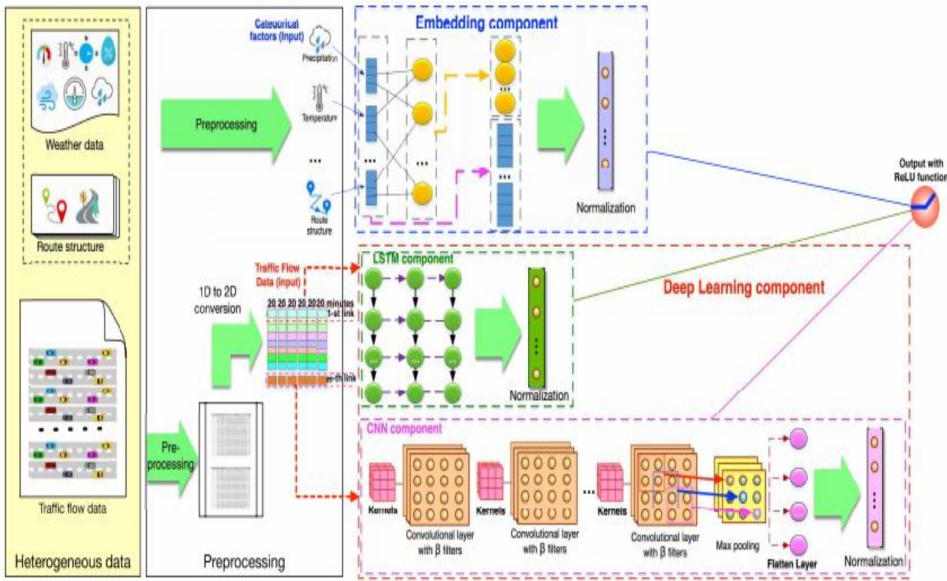
Figure 27. Deep learning approach for urban traffic flow prediction